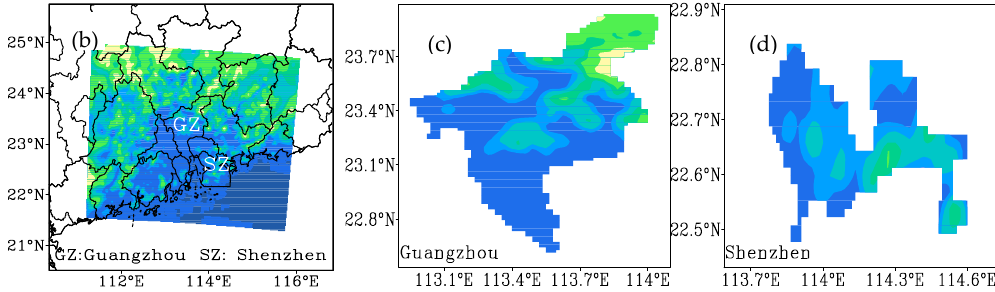
Figure 1. ( a ) Model domain and ( b – d ) terrain height distributions over ( a ) the simulated domain (D1), ( b ) PRD (D5), and ( c ) Guangzhou and ( d ) Shenzhen cities (units: m).